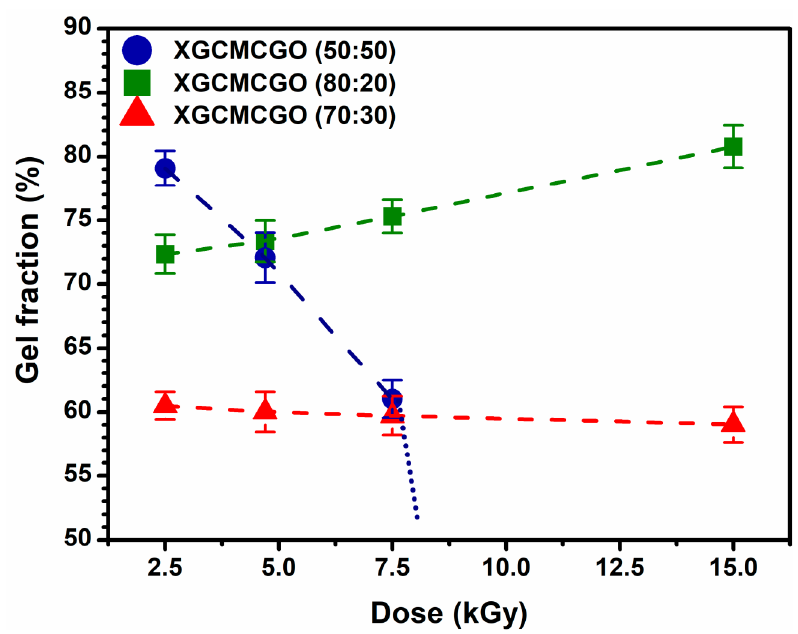
Figure 1. Gel fraction as a function of the absorbed dose during e-beam irradiation for the XGCMCGO hydrogels.